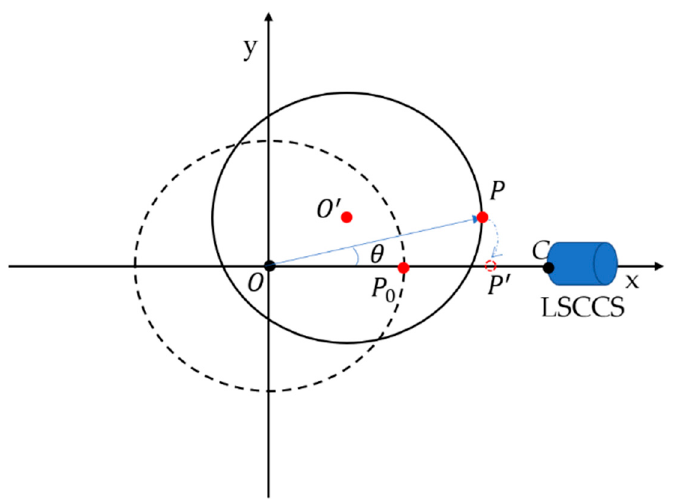
Figure 9. Schematic diagram of wafer eccentric coordinate system.